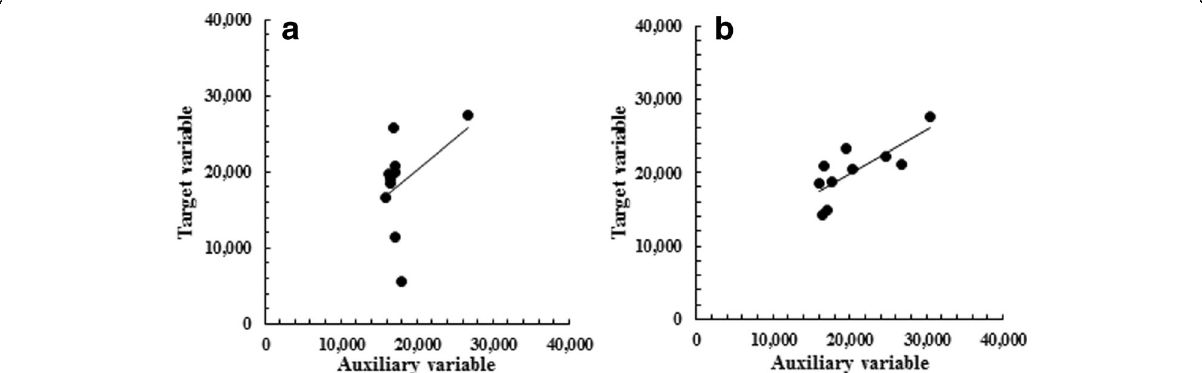
Fig. 2 Examples illustrating problems with model-assisted estimation. Two examples are shown of second-phase simple random samples, of size 10, chosen from amongst the 5000 simulations done with population example 2, the stocking density of Japanese rainforest, with a first-phase sample size of 30 and where the target-auxiliary variable correlation over the population had been set at r = 0.7. In both cases, the solid line shows the ordinary least-squares straight-line fit to the target-auxiliary variable data, that is, the model used to obtain model-assisted estimates of the population mean using Eq. (6.2). In the case of a the estimates of the parameter values were α = 3533 and β = 0.083, but the correlation level between the target and auxiliary variable data was r = 0.51, which was not significantly different from zero (at p = 0.05). In the case of b , α = 7800, β = 0.604 and the correlation was r = 0.77, which was significantly greater than zero (at p < 0.01 at